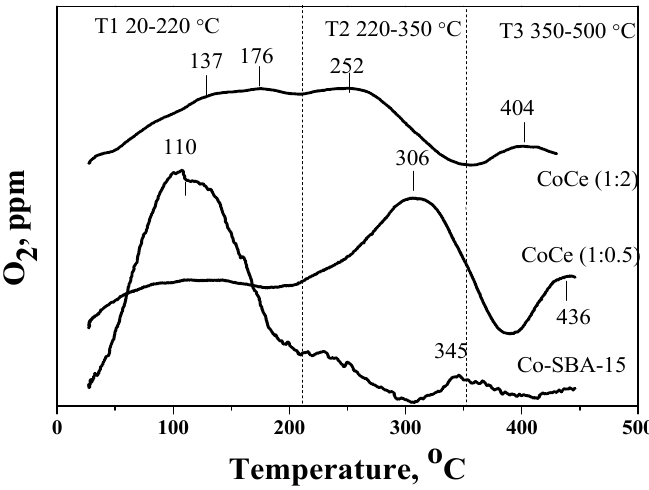
Figure 7. O 2 -TPD profiles of single- and bi-component